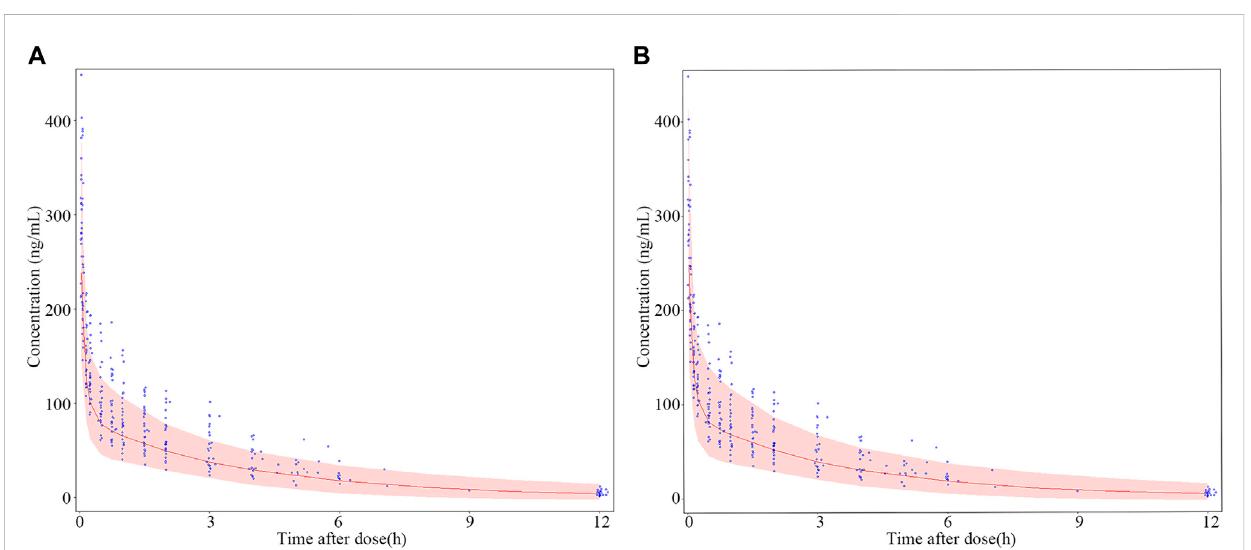
FIGURE 8 Dosageregimensimulationplotsofnalbuphine. (A) fi xeddosingregimen(12 mg); (B) bodyweightdosingregimen(0.2 mg/kg).Thebluepointswere the observed concentration. The red lines represent the 50th percentiles of simulated concentrations distribution in each panel. The shadow represent 5thand95thpercentilesofsimulatedconcentrationsdistributedineachpanel.Twoobservedconcentration(621 μ g/mLand778.1 μ g/mL)at0.05 hwere not shown in this